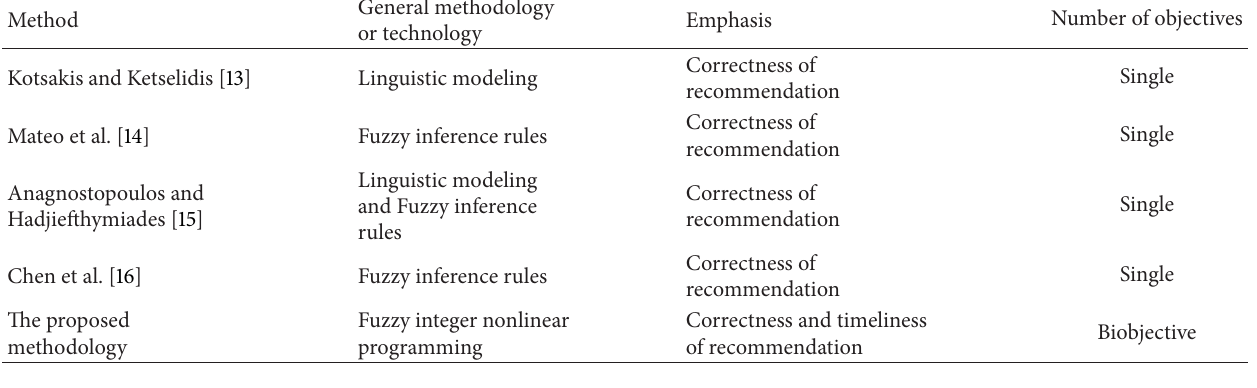
Table 1: Differences between the proposed methodology and some existing methods.